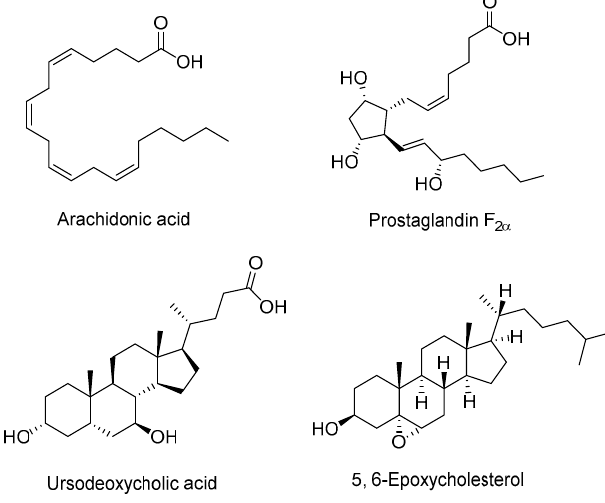
Figure 3. Representative endogenous ligands that inhibit LXRs (antagonists).